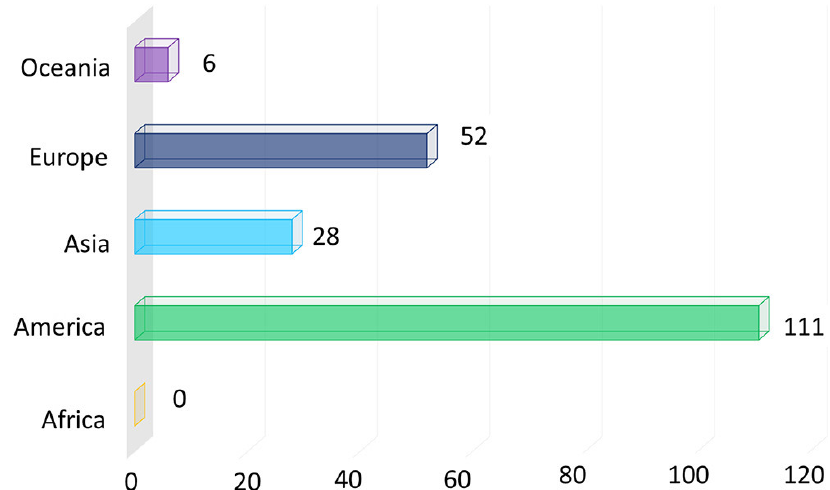
Fig. 4. Quantity of items collected by